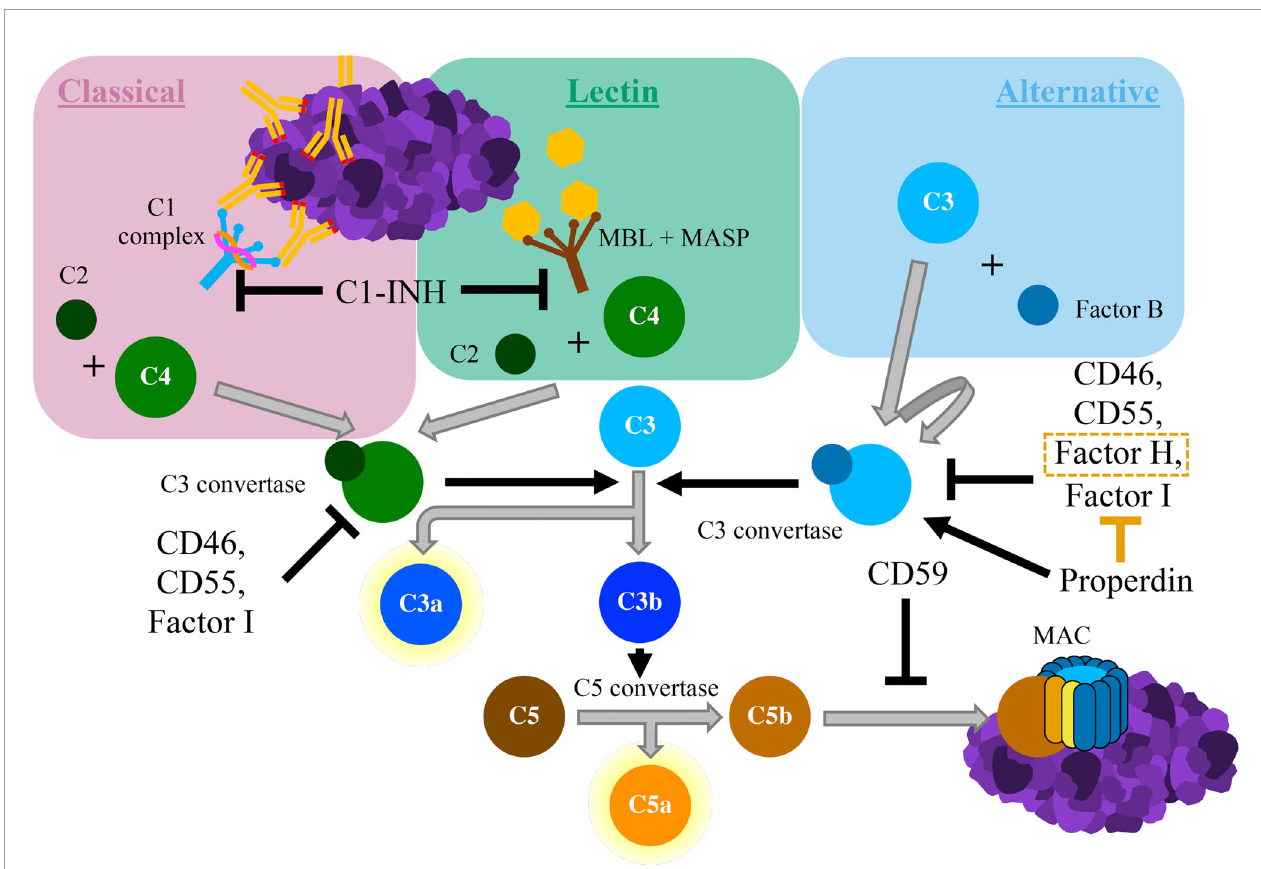
FIGURE 1 | Schematic diagram of the complement cascade. The classical pathway begins with the binding of the C1 complex to antigen-antibody complexes containing IgG or IgM. The lectin pathway is triggered by the binding of mannose-binding lectin (MBL), which is bound to proteolytic MBL-associated serine proteases (MASPs), to carbohydrate moieties. Both of these pathways result in cleavage of C2 and C4 to form C3 convertase. The alternative pathway starts with the autoactivation of C3, typically via direct binding of C3 to pathogens. This creates a unique version of C3 convertase that involves the cleavage of Factor B All complement pathways converge with the cleavage of C3 into C3a and C3b. C3b associates with C3 convertase, which cleaves C5 into C5a and C5b. The anaphylatoxins C3a and C5a have potent proin fl ammatory effects. C5b deposits on cell surfaces, where it forms the membrane attack complex (MAC), which induces cell lysis. Various inhibitory proteins disrupt the complement cascade, as labelled within the fi gure